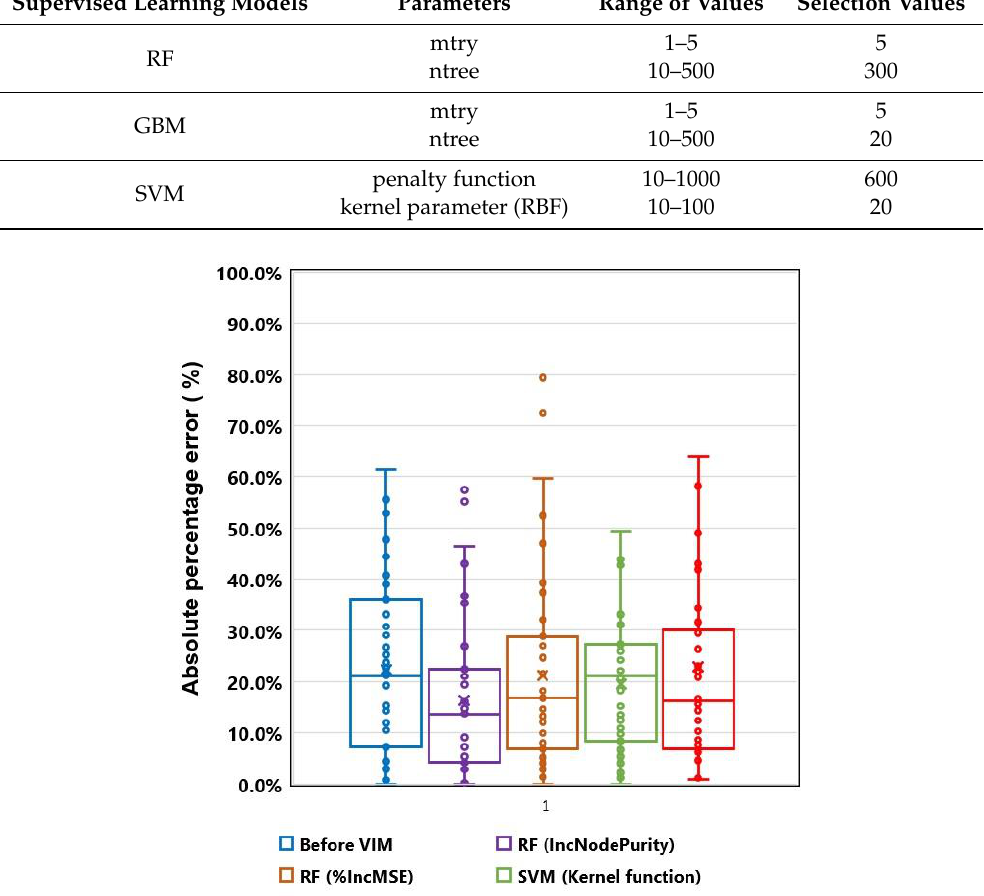
Figure 12. Boxplot of absolute percentage error for supervised learning models before and after variables importance method